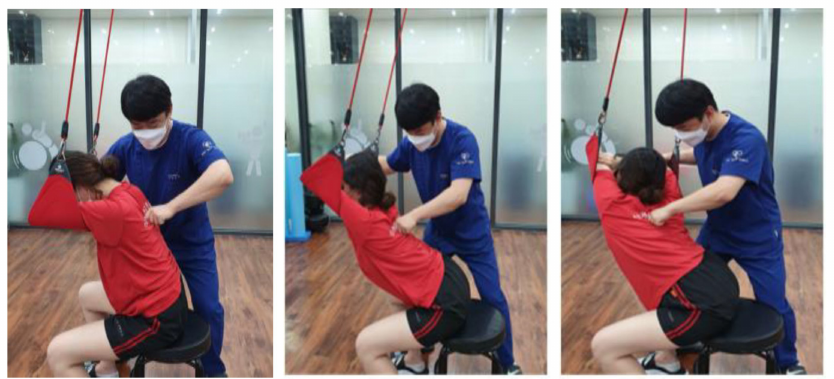
Figure 2. Thoracic active exercise with a sling.